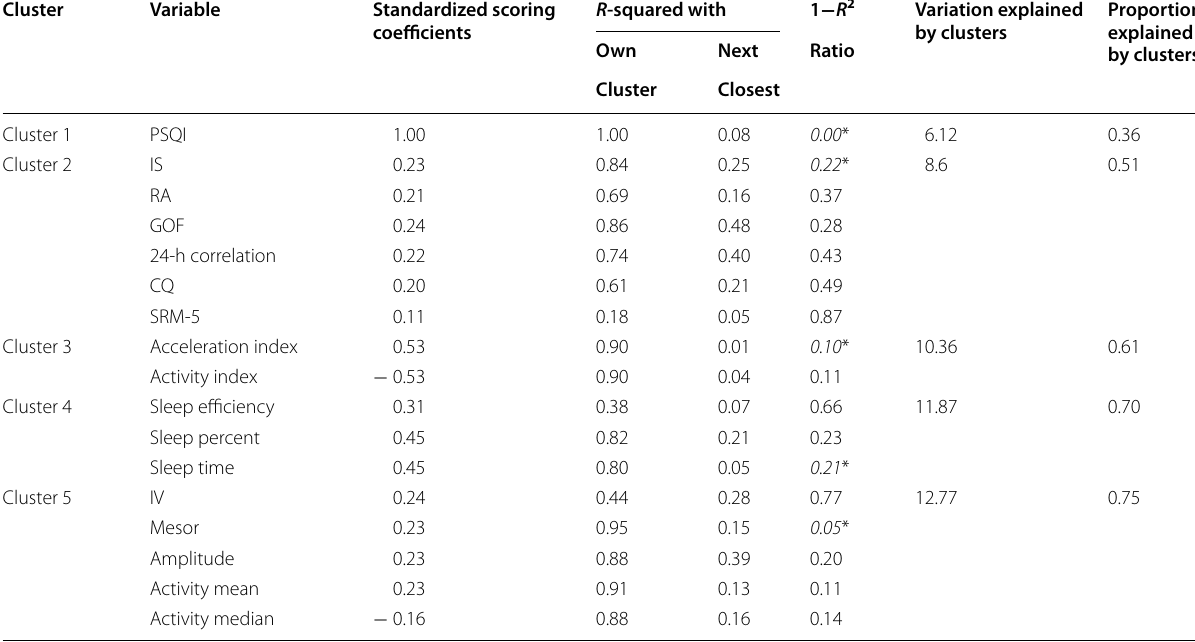
Table 2 Cluster analysis